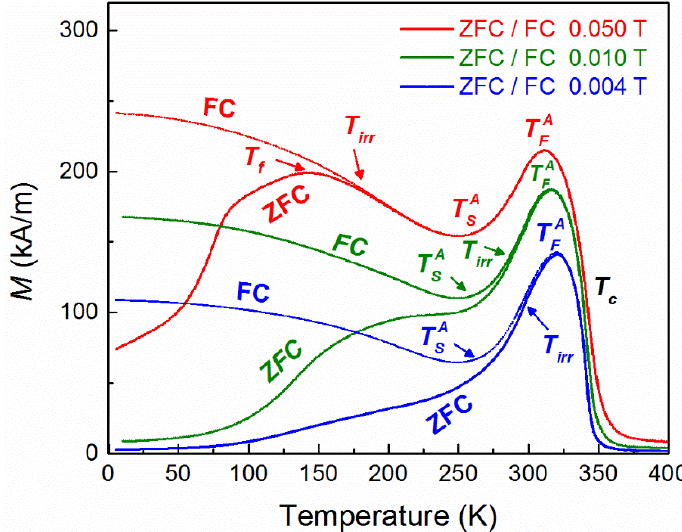
Figure 3. Zero-field cooling and field cooling magnetization curves for various cooling fields.